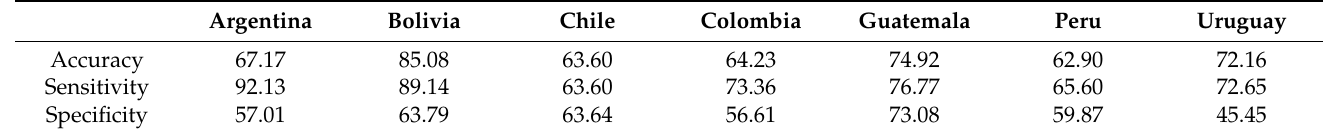
Table 8. LASSO confusion matrix, process